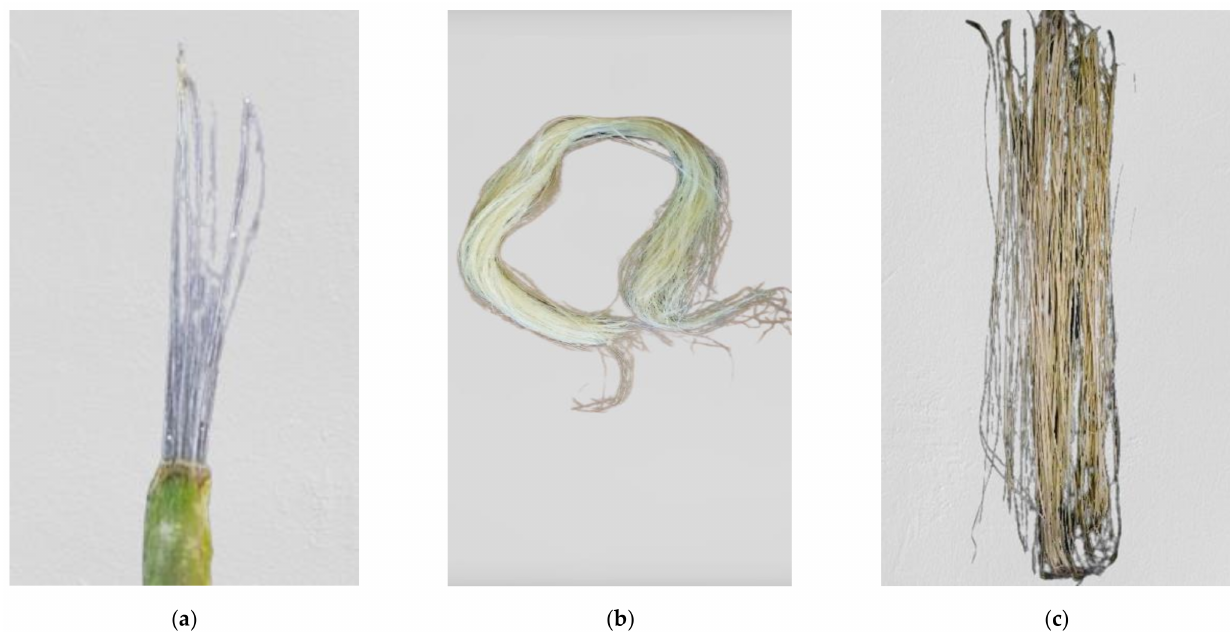
Figure 1. PALF isolation process: ( a ) Isolated fiber from the leaf; ( b ) drying at room temperature; ( c ) NaOH treated